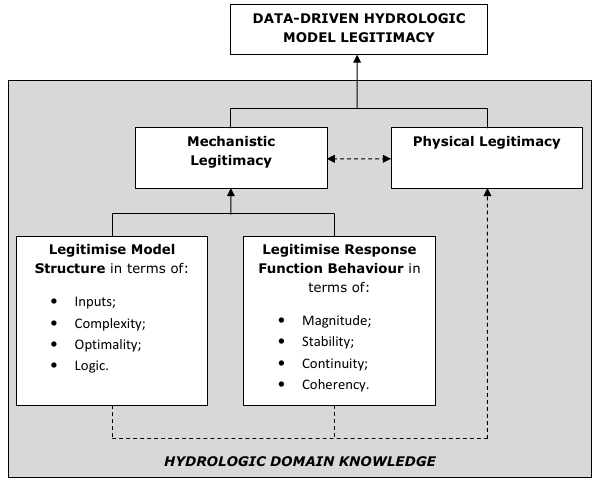
Figure 1. Conceptual elements in the legitimisation of data-driven hydrologic models. Fig. 1. Conceptual elements in the legitimisation of data-driven hy- Dashed lines indicate the potential for the interaction of mechanistic and physical legitimacy. drological models. Dashed lines indicate the potential for the inter- action of mechanistic and physical legitimacy.